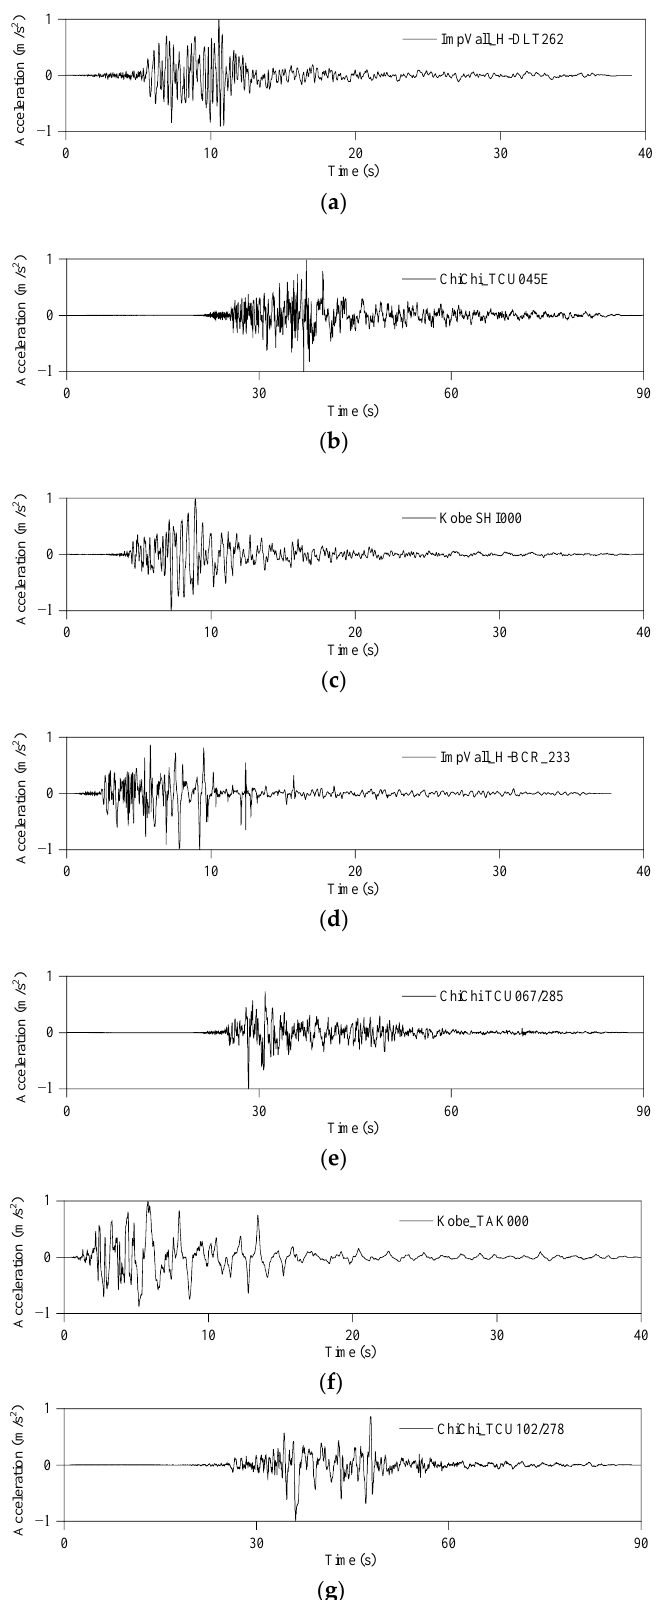
Figure 3. History of acceleration of the earthquake ground motions: ( a ) Imp_F; ( b ) Chihi_F; ( c )